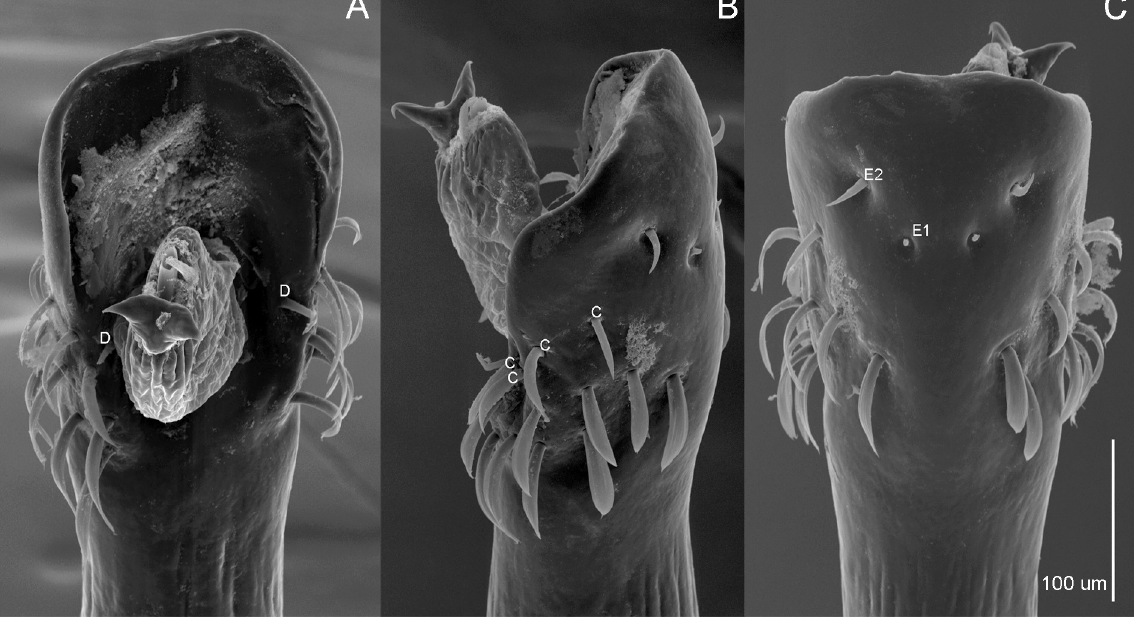
Fig. 3. Troglostygnopsis anophthalma Šilhavý, 1974, ♂, topotype (AMNH), penis. A . Dorsal view. B . Lateral view. C . Ventral view. Scale bar in C applicable to all